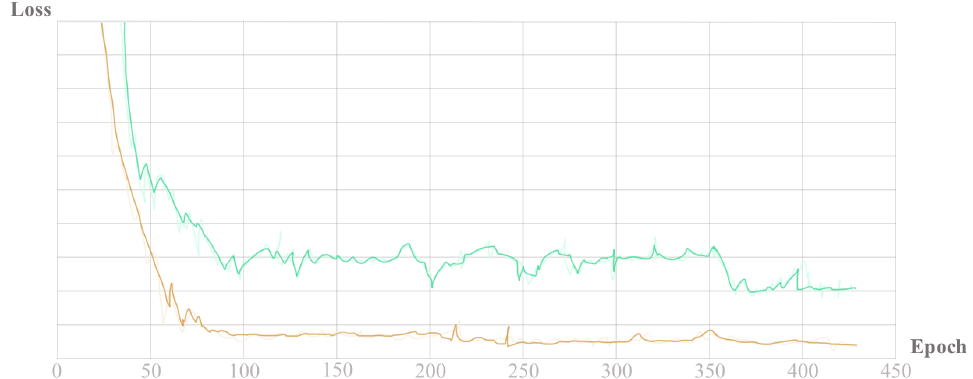
Figure 9. Training curves of loss against number of epochs (yellow: training set; green: validation set).